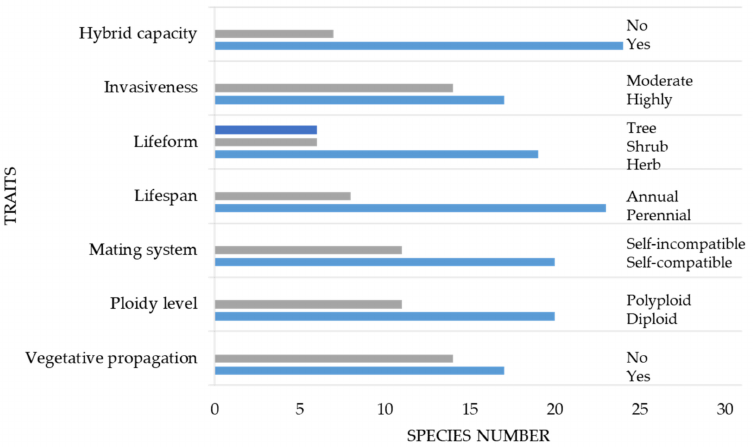
Figure 2. Plant species analyzed in the meta-analysis. The X -axis shows the number of species, and the Y -axis shows each of the seven moderators used. The bars show the categories within each moderator.